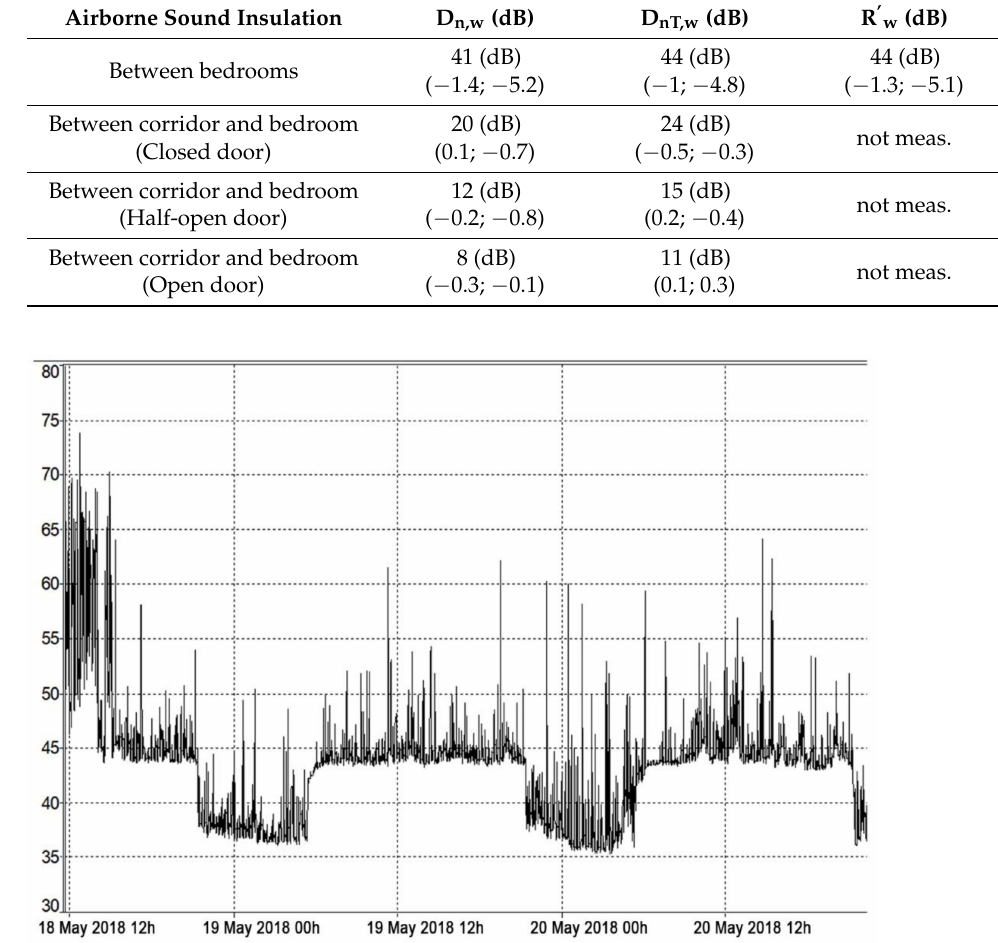
Figure 7. Time history of the whole sound pressure level measurement carried out in an unoccupied